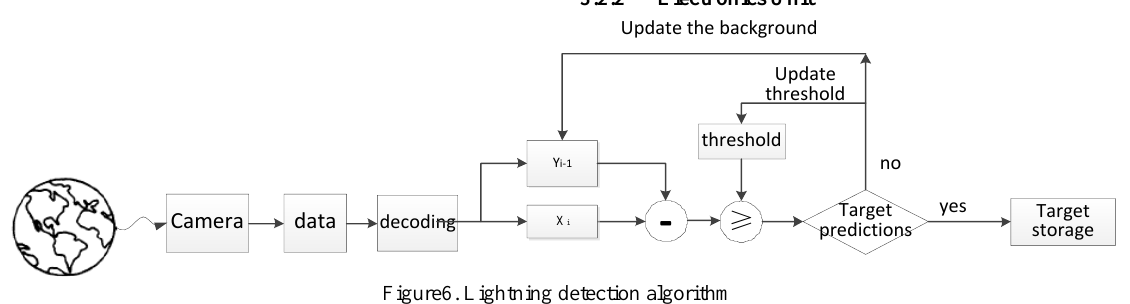
Figure6. Lightning detection